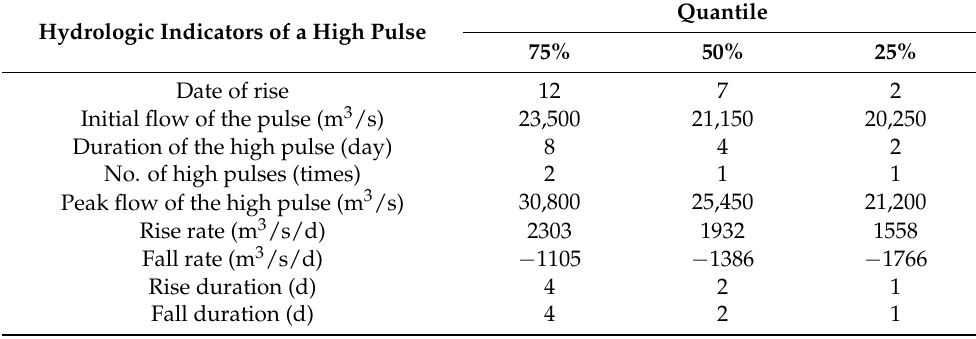
Table A1. Components of the Indicators of Hydrologic Alteration (IHA) results used to develop the artificial flood pulse flow.